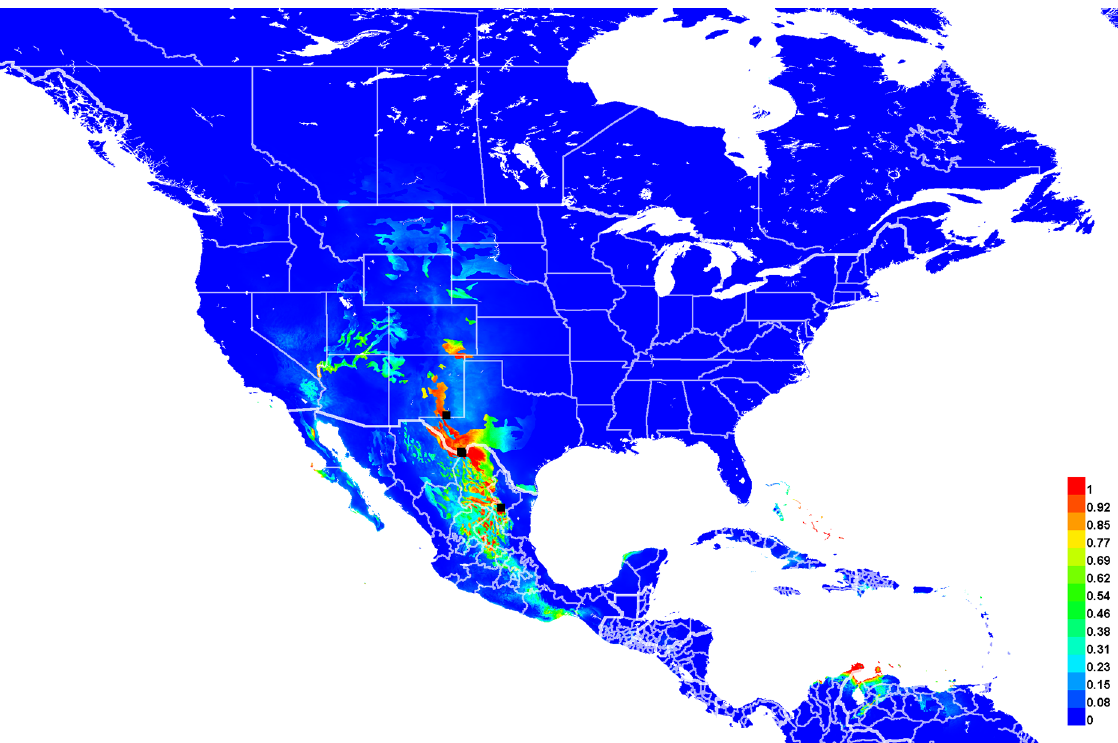
Fig. 35. Georeferenced collection records of Lasioglossum ( D. ) droegei Gibbs, 2009 (black squares) and predicted distribution by maximum entropy ecological niche modeling in Maxent (colour shading). Warmer colours indicate higher cloglog probability of occurrence. The predicted distribution was generated with a regularization multiplier of 0.5 to obtain a more conservative prediction. Due to the very small number of records, this distribution should be interpreted with